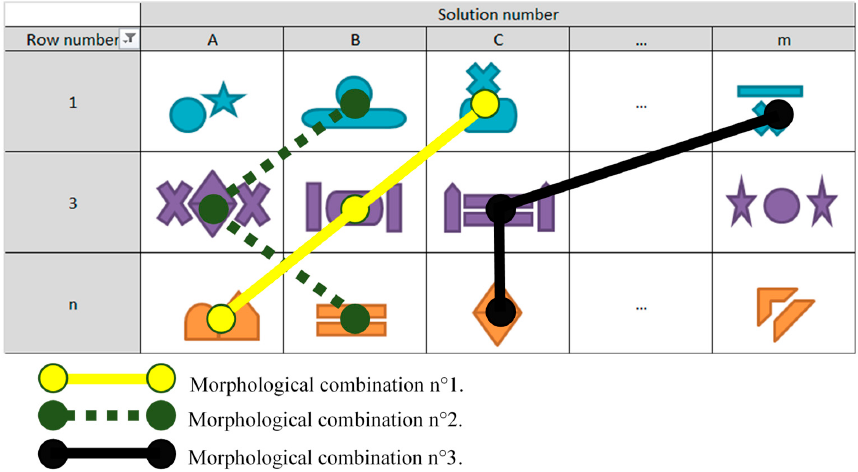
Figure 4. Generic example of a whole chart with all the rows, without filters. It shows all the available solutions in the white boxes for all the PSN ramifications. It cannot be used as a morphological chart.